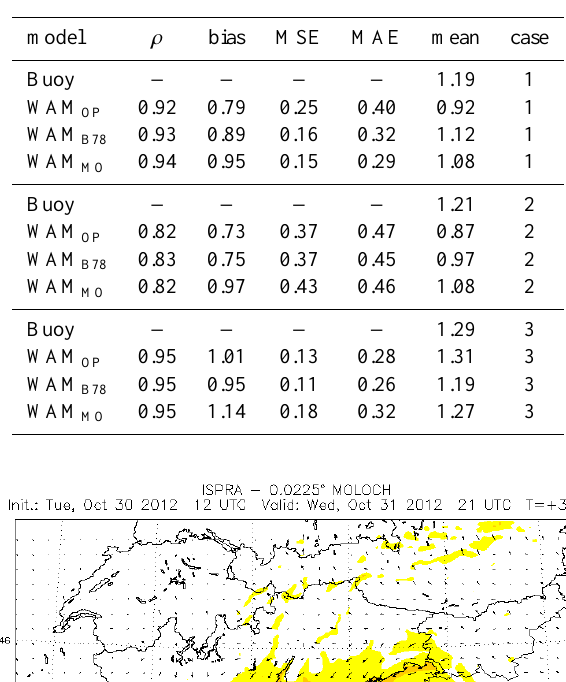
Table 1. Statistics for the Ancona forecast verification.